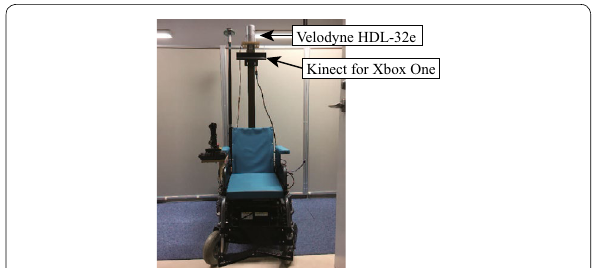
Fig. 5 Mobile robot system equipped with an omni-directional laser scanner (Velodyne HDL-32e) and an RGB-D camera (Kinect, Microsoft)